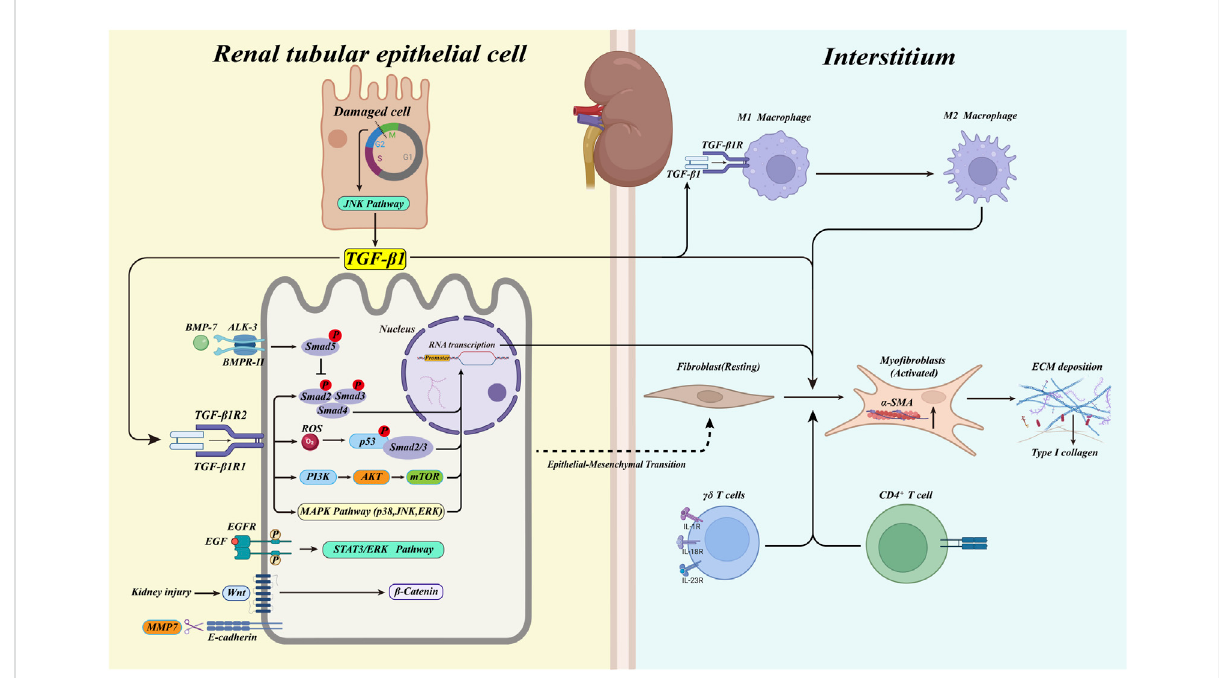
FIGURE 1 The activated TGF- β 1/Smad pathway initiates the transcription of pro- fi brotic factors when the kidney damaged. At the same time, myo fi broblastsintherenalinterstitiumareactivatedandproducelargeamountsofECM.InresponsetoTGF- β 1,renaltubularepithelialcellsundergo phenotypic conversion to fi broblasts (type 2 EMT). Immune cells in fi ltrate in the renal interstitium, triggering the deposition of ECM. Macrophages convert from type M1 to type M2 in response to TGF- β 1, promoting fi brosis. BMP-7 activates the phosphorylation of Smad5, which plays a protective role against the TGF- β 1/Smad pathway. Blocked G2/M phase of cell cycle in damaged tubular epithelial cells activates the JNK pathway and promotes the production of TGF- β 1. Meanwhile, MAPK kinases activated by TGF- β 1, p53, EGF, and Wnt/ β -catenin pathways are also involved in the renal fi brosis